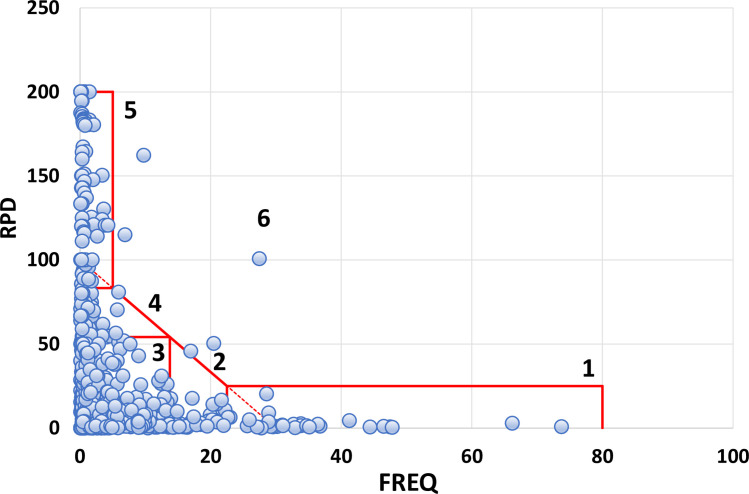
Distribution of taxa within uncertainty/frequency categories (UFC1-6).Uncertainty is expressed as relative percent difference (RPD) and relative rarity or commonness as frequency of observation (FREQ). Each point represents a taxon.